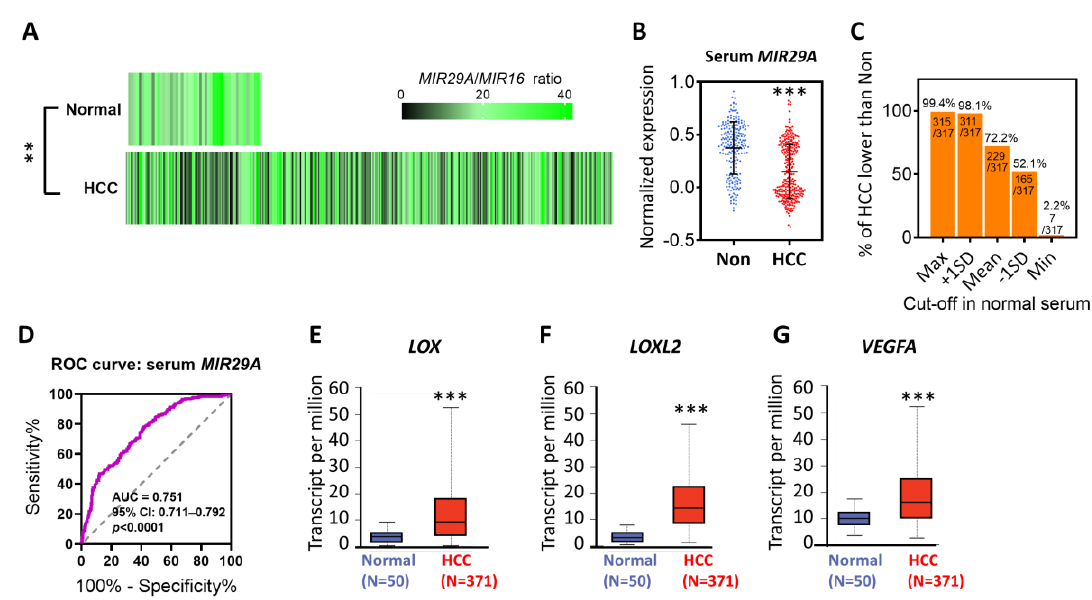
Figure 1. Differential expression analysis of MIR29A , LOX , LOXL2 , and VEGFA in HCC patients as compared to normal individuals. ( A ) Heatmap of MIR29A expression level in normal tissue and HCC, wherein 51 and 375 TCGA datasets were respectively accessed in the OncoMir Cancer Database (OMCD). MIR16 expression level served as normalization control. ** p < 0.01 between normal and HCC group. The raw data of TCGA samples retrieved from OMCD are shown in Supplementary File S1. ( B ) Serum MIR29A expression level of HCC patient and non-cancer individuals retrieved from the GSE113740 dataset. MIR16 expression level served as the normalization control. *** p < 0.001 between the non-cancer (Non) and HCC group. ( C ) The number (%) of HCC patients presenting a lower value than normal individuals at the cut-off of maximum, mean + 1SD, mean, mean-1SD, and minimum value of normal serum. ( D ) Receiver operating characteristic (ROC) curves for non-cancer and HCC cohorts based on serum MIR29A levels from the GSE113740 dataset. The gene expression level of LOX ( E ), LOXL2 ( F ), and VEGFA ( G ) in HCC and normal tissue retrieved from TCGA datasets. ** p < 0.01, *** p < 0.001 between the normal and HCC group. Panel E, F and G were adapted form UALCAN, which is an open assessed web server.